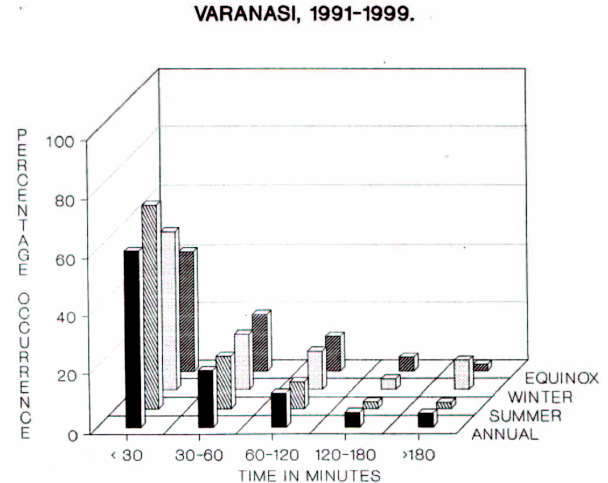
Fig. 1. Percentage occurrence of patch duration is given for dif- ferent seasons of 1991–1993 and 1998–1999. The mean values of patch duration in the summer, winter and equinox seasons are 23, 34 and 36min,